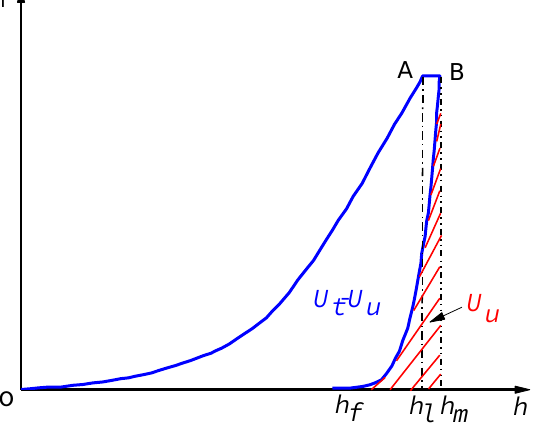
Figure 4. Schematic illustration of shale micro-indentation load-displacement curve.